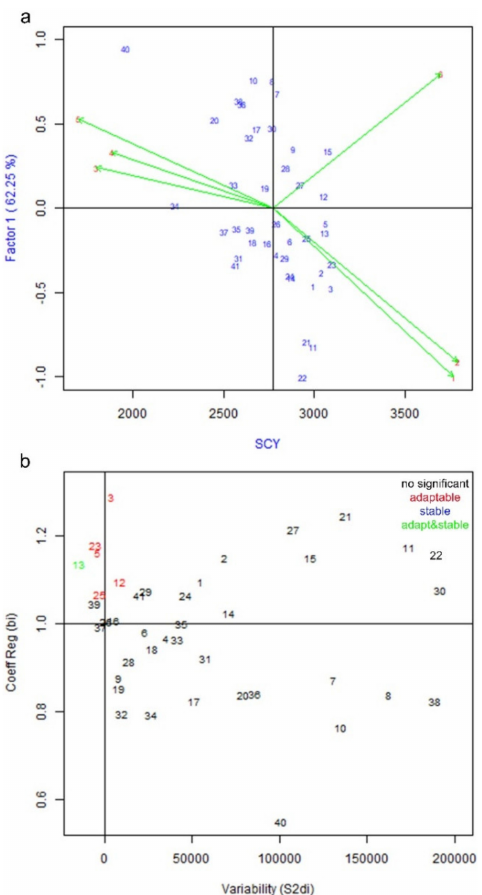
Figure 2. Mean performance and stability of 41 genotypes at six environments for seed cotton yield (SCY). ( a ) Represents the mean of SCY (kg / hec) on the X-axis and the first interaction principal component (IPC1) scores of GEI on the Y-axis. Blue and red colored numbers inside the biplot show genotypes and environments, respectively. ( b ) Shows stability analysis of SCY, coe ffi cient of variability (X-axis) and coe ffi cient of regression (Y-axis). All numbers inside the biplot show genotypes. See Tables 1 and 2 for code description of genotypes and environments,